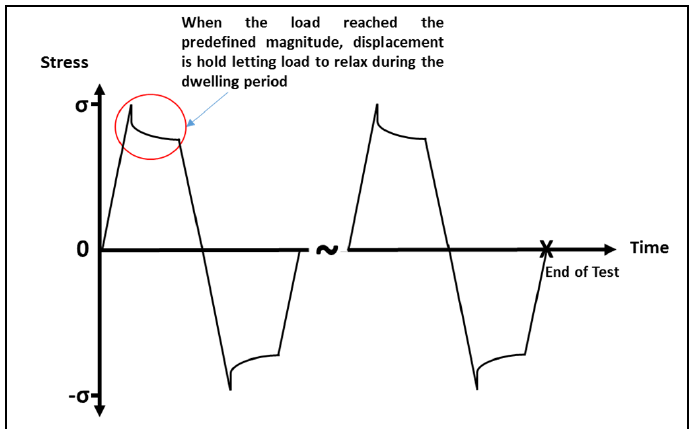
Figure 6. Combined creep–fatigue testing profile.